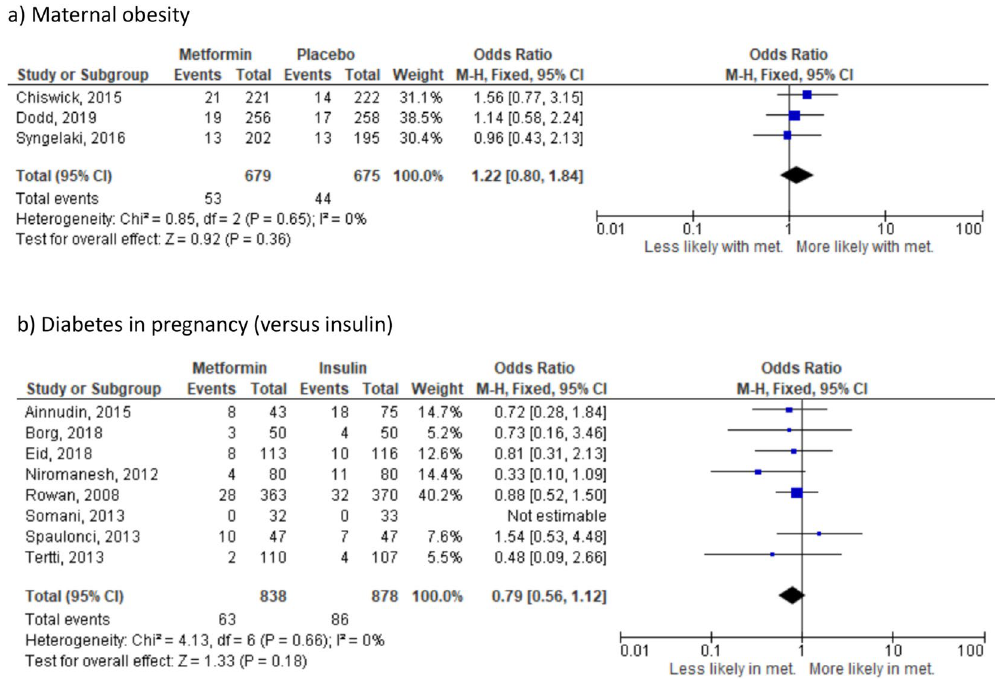
Figure 3. Effect of metformin randomisation upon gestational hypertension (all indications), based on 14 studies including 4189 pregnancies. Odds ratio, fixed-effects model, 95%